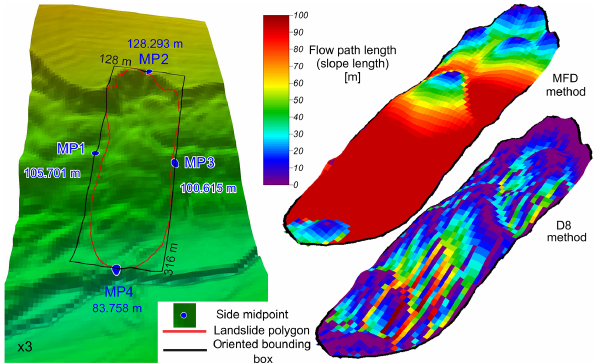
Figure 7. Three-dimensional view of a long landslide (left) and the flow lengths for it (right) (MFD is the flow length computed with the Multiple Flow Direction algorithm, and D8 is the flow length computed with the Deterministic 8 algorithm).